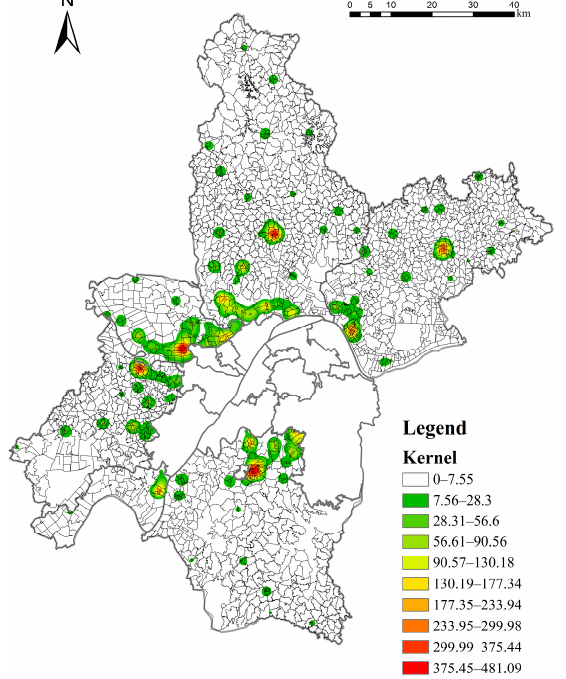
Figure 4. Kernel density of market services industries in Wuhan city’s new urban districts.